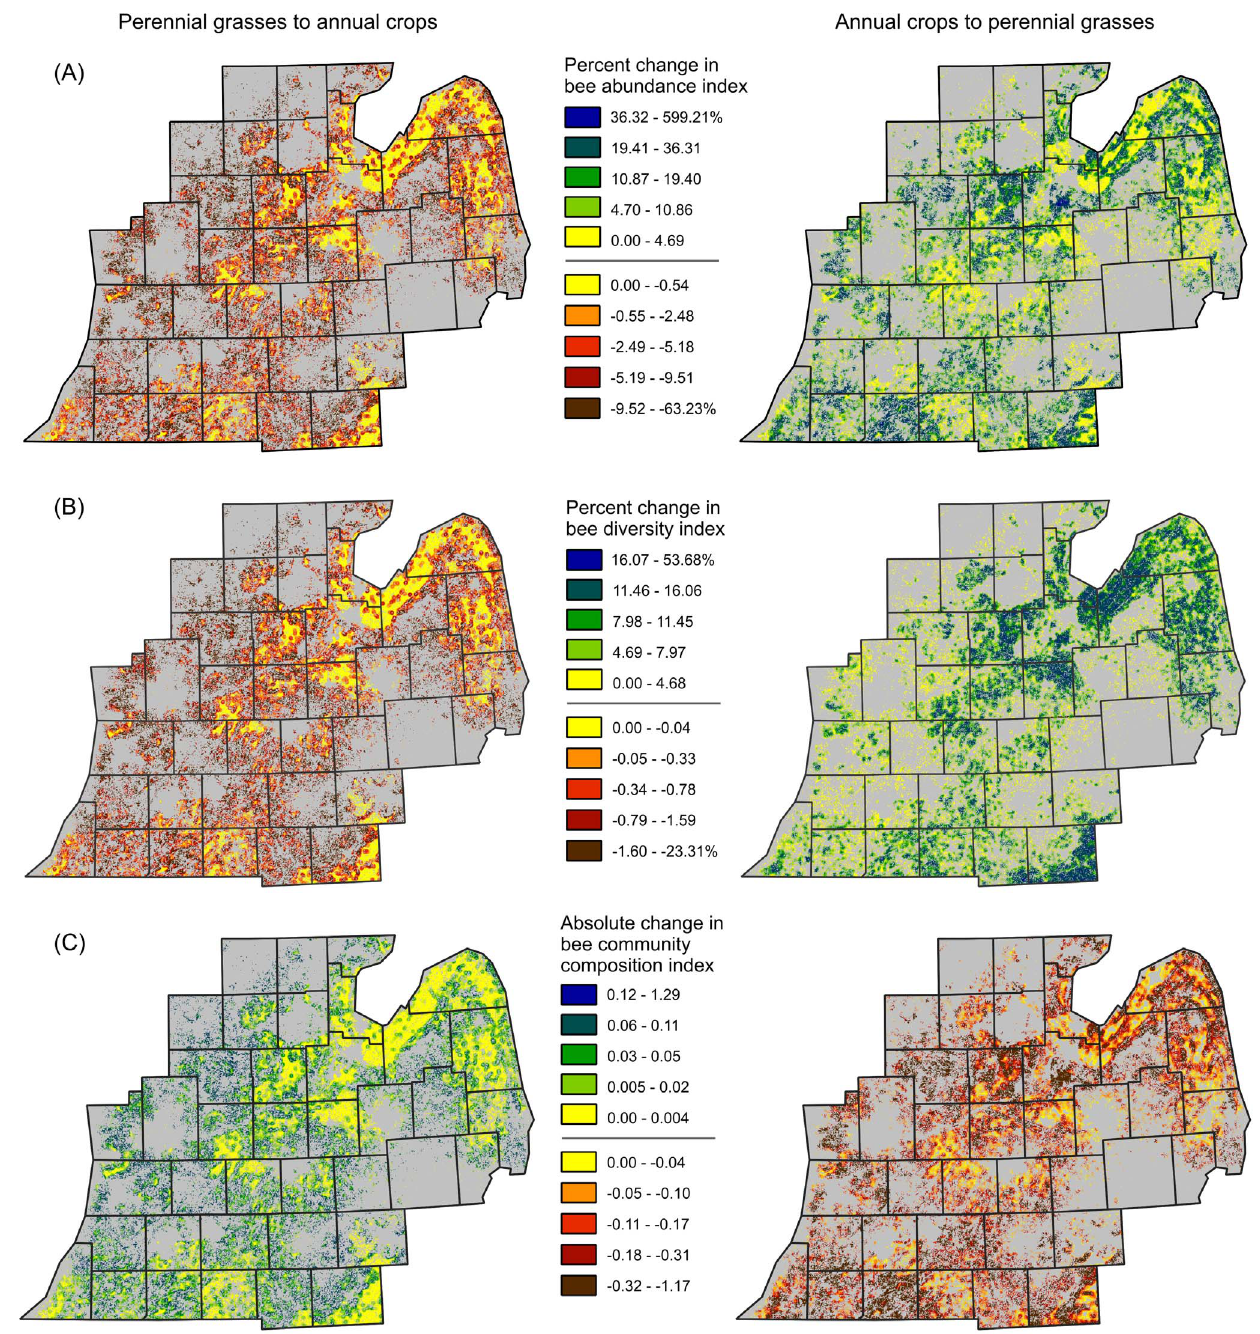
Figure 5. Projected bee metrics. Percent change in bee abundance (A), percent change in bee diversity (B), and difference in community composition (C) predicted for Michigan by an empirical model under annual (left maps) and perennial (right maps) bioenergy production scenarios.